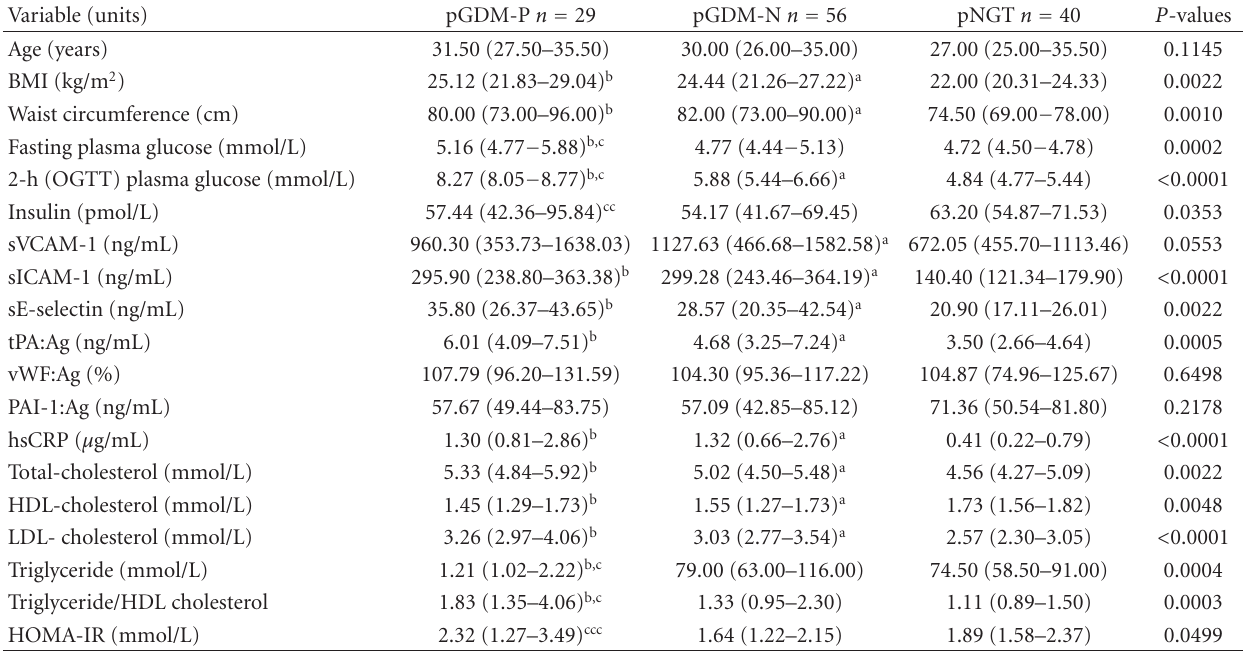
Table 2: Clinical and laboratory data for participants in studied groups: pGDM-P, pGDM-N and pNGT as a control group. Variable (units)